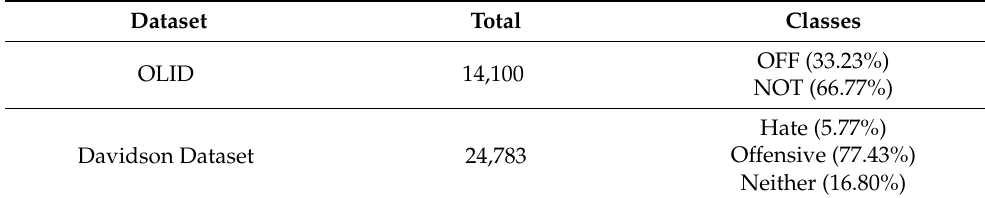
Table 2. Statistics of